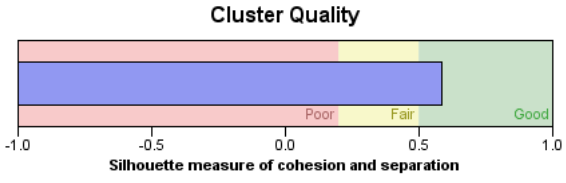
Figure 15. Silhouette measure of cohesion and